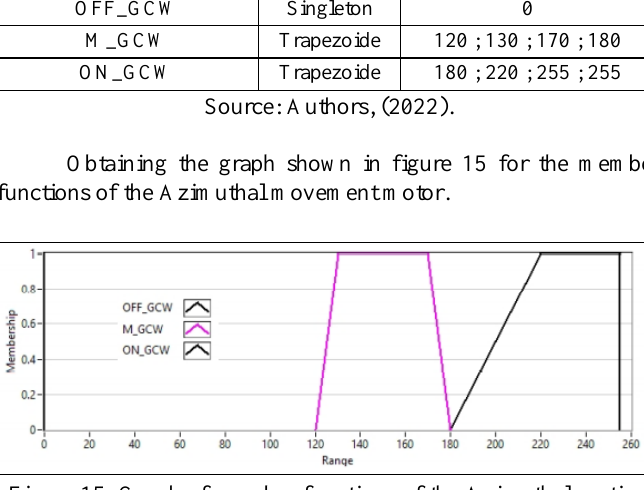
Figure 15: Graph of member functions of the Azimuthal motion